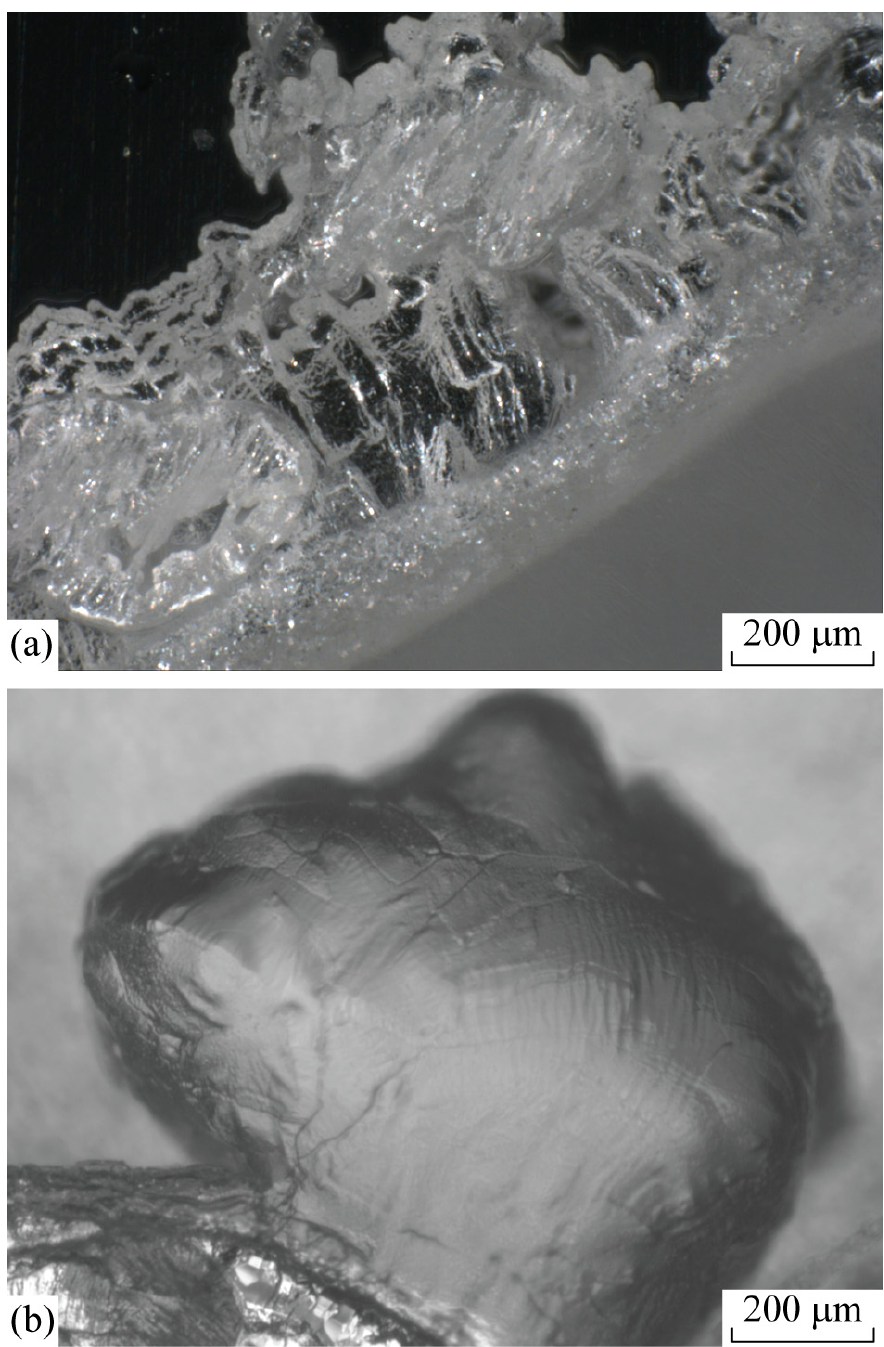
Figure 9. Massive form of xenon hydrate: ( a ) Hydrate formed at − 10 °C, 8 atm; observed at +9 °C, 8 atm; ( b ) Hydrate formed at − 10 °C, 8 atm; observed at +9 °C.